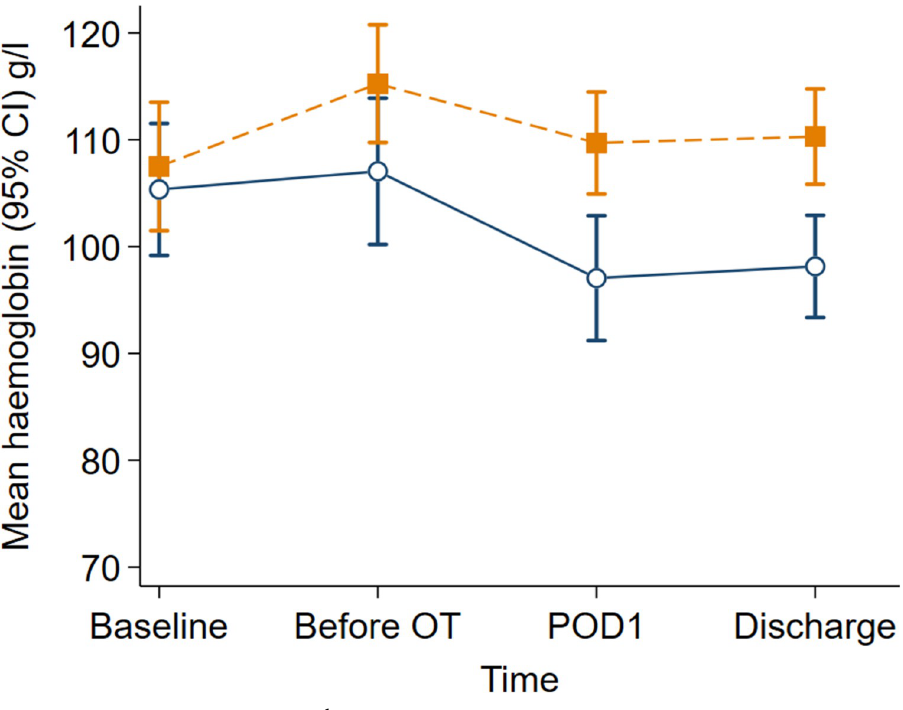
Fig 2. Haemoglobin concentrations (g. -1 ) over time by treatment groups. Data are mean with error bars showing the 95% confidence interval. Intravenous iron isomaltoside (filled orange squares with dash line); control (unfilled navy circles with solid line). OT, operating theatre; POD1, postoperative day